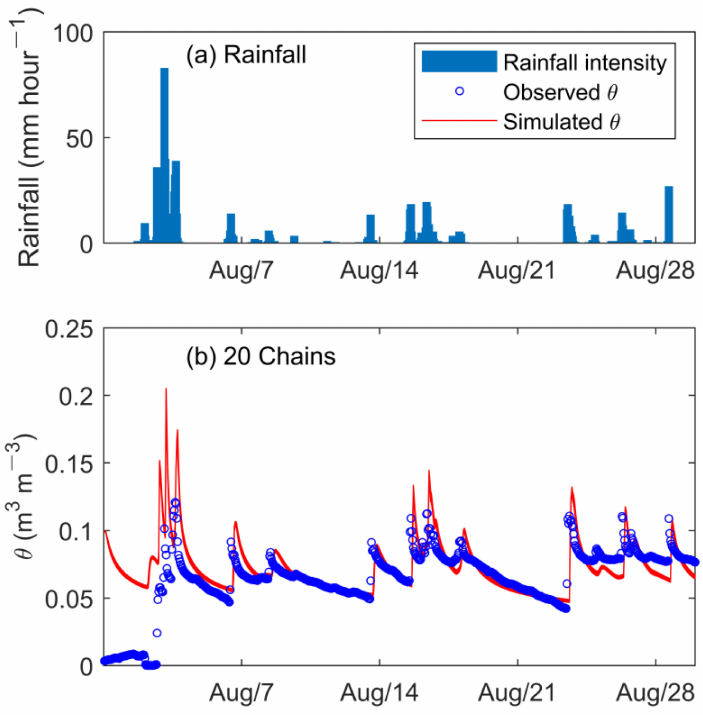
Figure 9. Comparison of calculated and measured soil moisture content